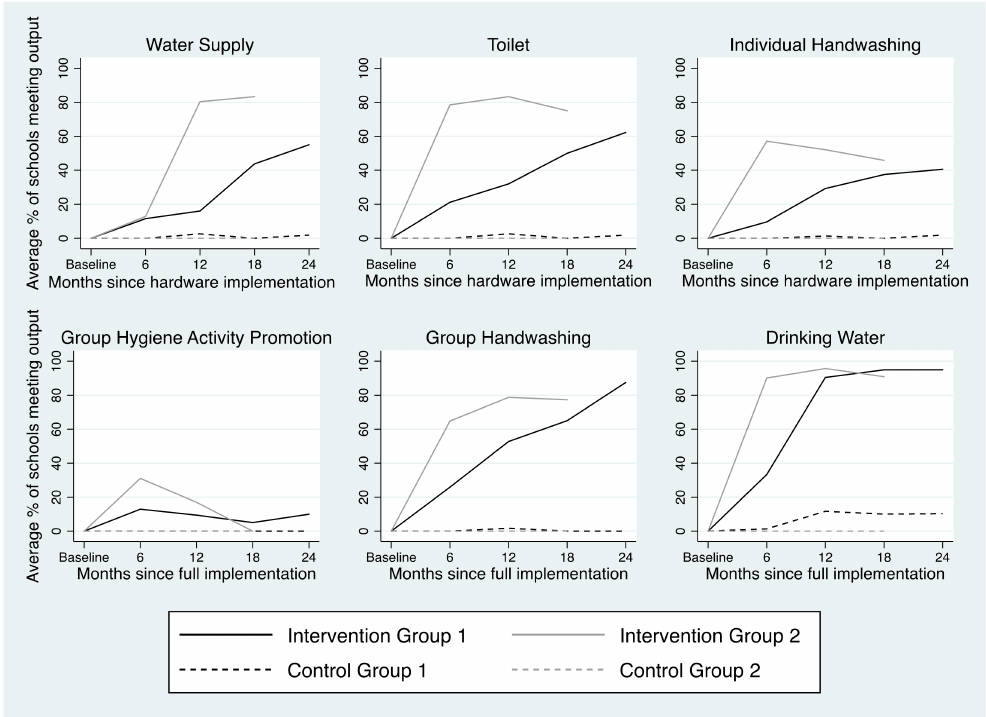
Figure 2. Achievement of project outputs by time since project implementation, stratified by intervention and implementation